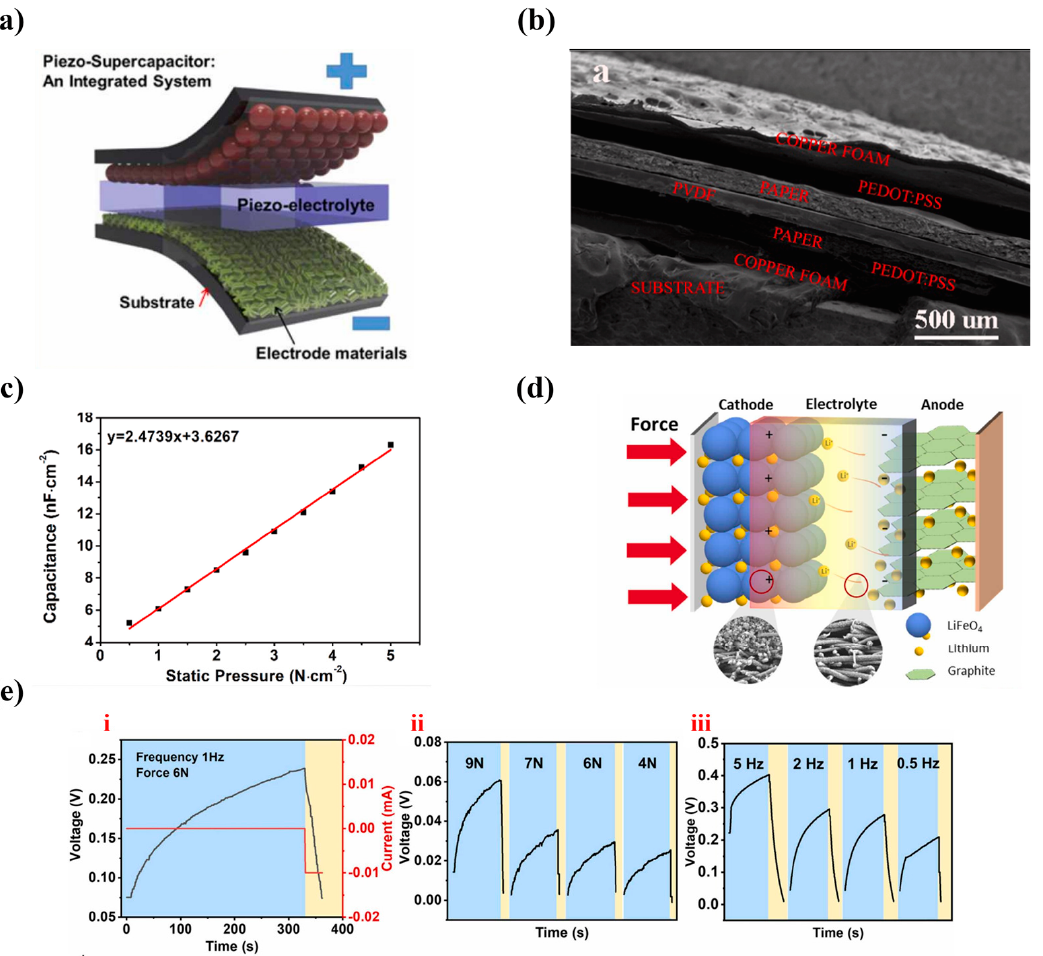
Figure 4. ( a ) Schematic of the PSCs. Reprinted with permission from Ref. [83]. Copyright 2021, Nano Energy. ( b ) SEM diagram of the tactile sensors based on PSCs. ( c ) Relationship between capacitance and externally applied static force. Reprinted with permission from Ref. [84]. Copyright 2019, Nano Energy. ( d ) Schematic of the SCPCs. The self-charging performance of flexible SCPC: ( e ) i. periodic external force; ii. different force strengths; iii. force frequencies. Reprinted with permission from Ref. [85]. Copyright 2022, Nano Energy.